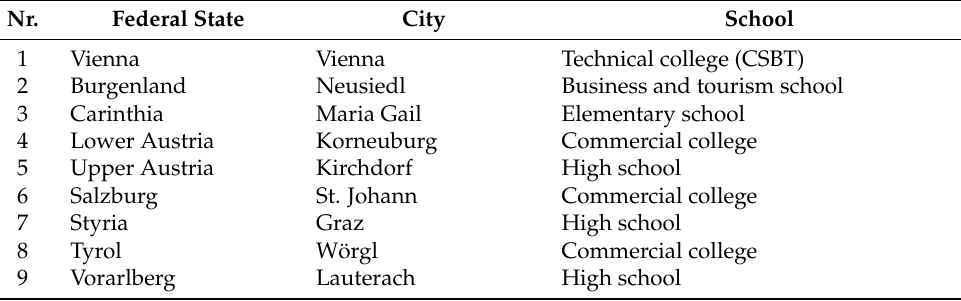
Table 3. Schools selected for implementation of low-cost greening measures.